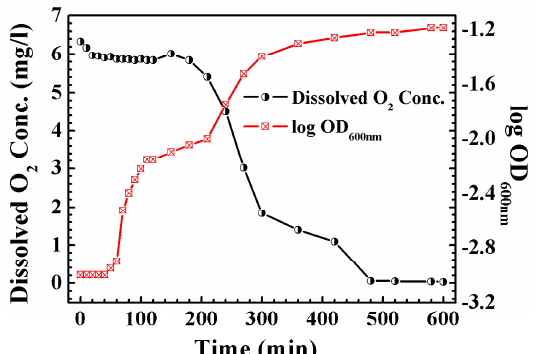
Figure 5. The variation in the dissolved oxygen concentration (mg/L) and OD 600nm (the absorbance of bacterial solution at 600 nm) (as a growth rate) in the bacterial solution versus time at 30 °C and 120 rpm speed. During the first 600 min of incubation, the oxygen concentrations were significantly decreased and reached their lowest value at 600 min of exposure; meanwhile, the OD 600nm value was incrementally increased from 0.001 to 0.06 and stayed stable.